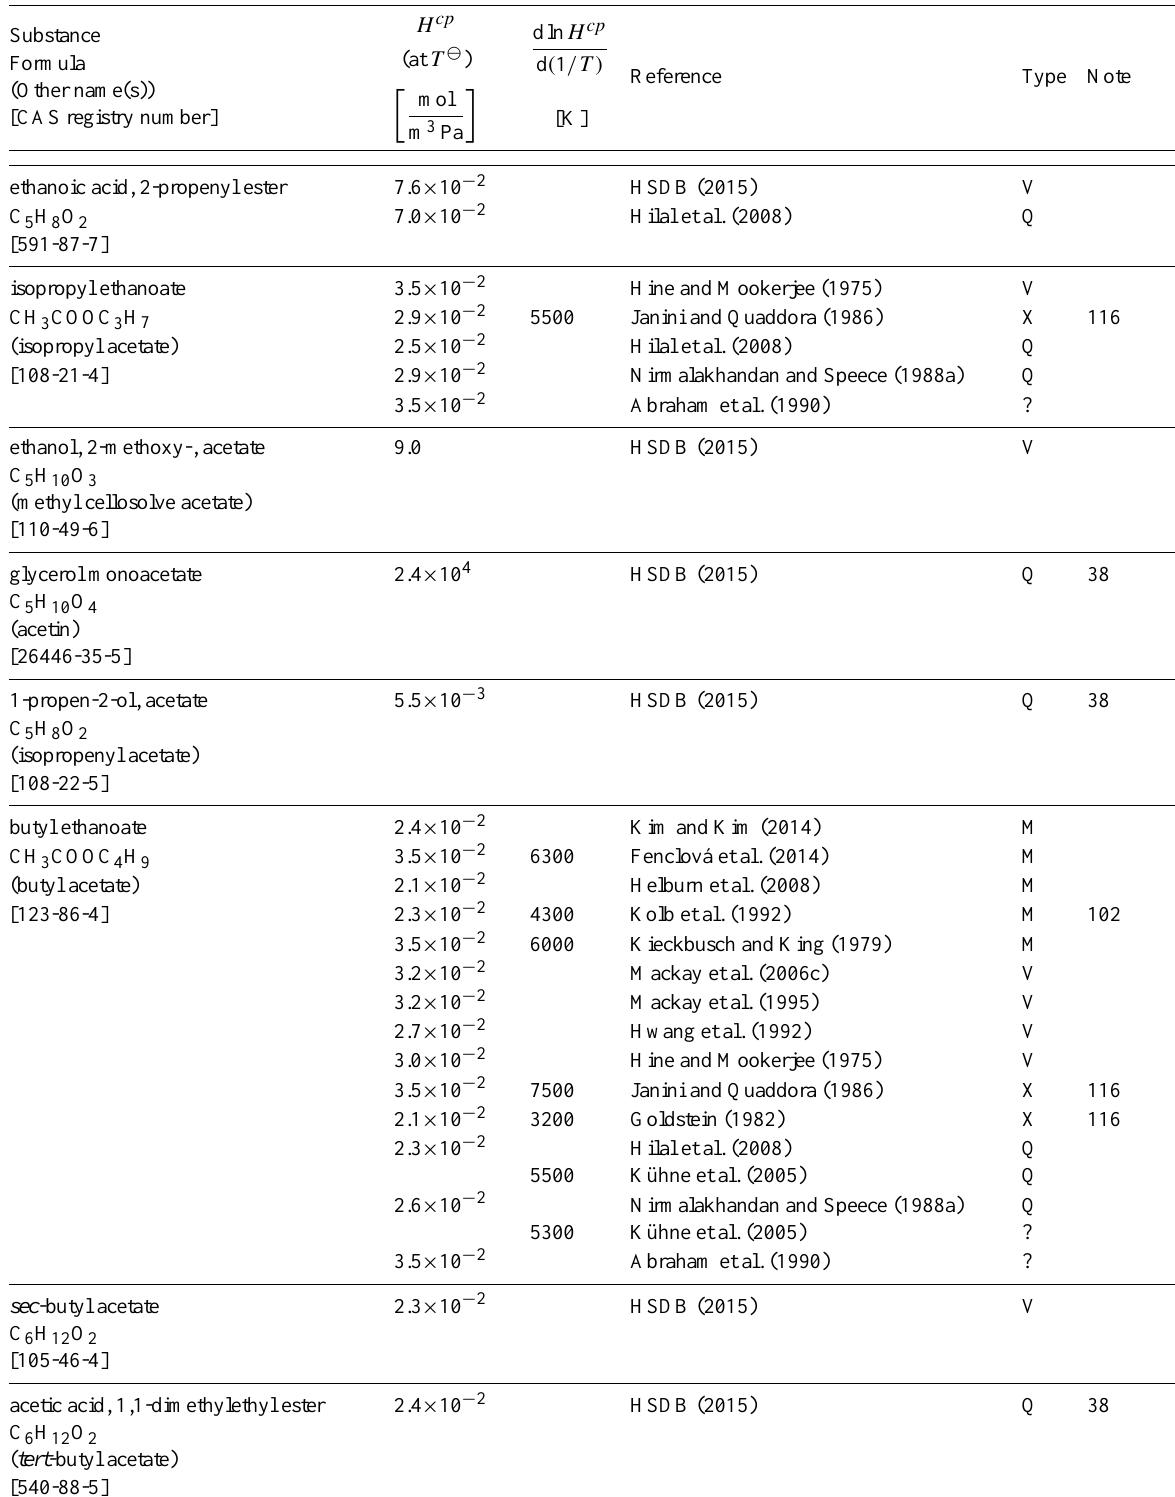
Table 6: Henry’s law constants for water as solvent